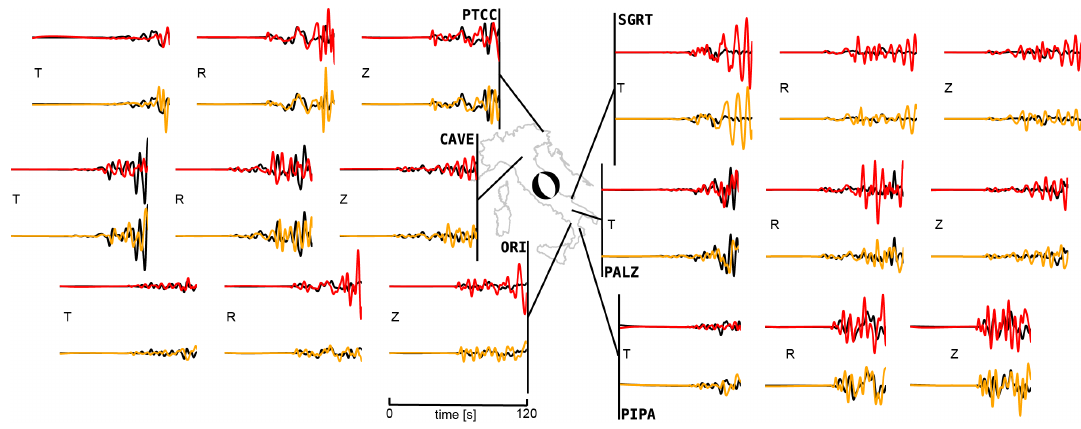
Figure 1: Comparison of data (black) and synthetics three-component velocity seismograms at selected stations of INSN network (red - velocity model [Di Stefano & Ciaccio, 2014]; green - velocity model IMAGINE_IT). Seismograms are 20-50 s lowpass-highpass filtered, the traces are 180 s long. The TDMT moment tensor solution is reported at http: // cnt. rm. ingv. it/ event/ 7073641